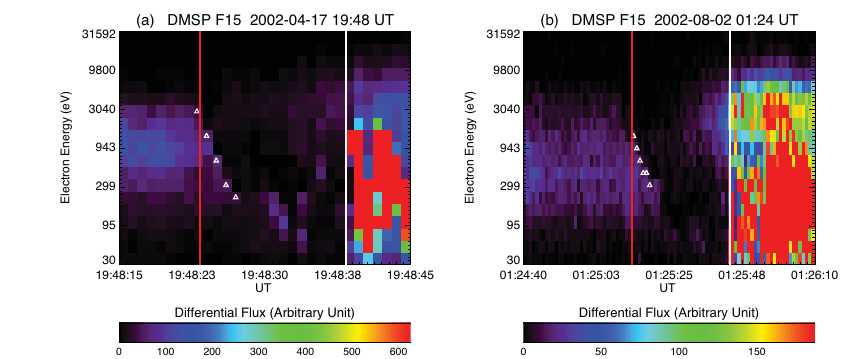
Figure 3. Polar rain electron dispersion observed by DMSP F15 at (a) 17 April 2002 19:48UT and (b) 2 August 2002 01:24UT. The white triangles, which indicate the highest energy detected at a given latitude, give a measure of the energy-latitude dispersion. The vertical red lines mark the location of the highest energy polar rain electrons in the dispersion region while the vertical white lines mark